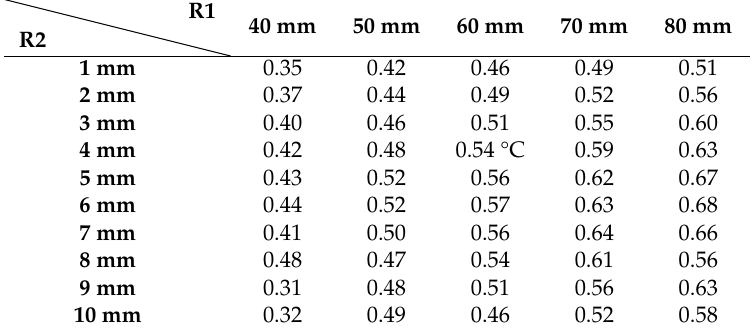
Table 2. Theoretical data for breast cancer analysis at various positions (X = 10, Y = 10).